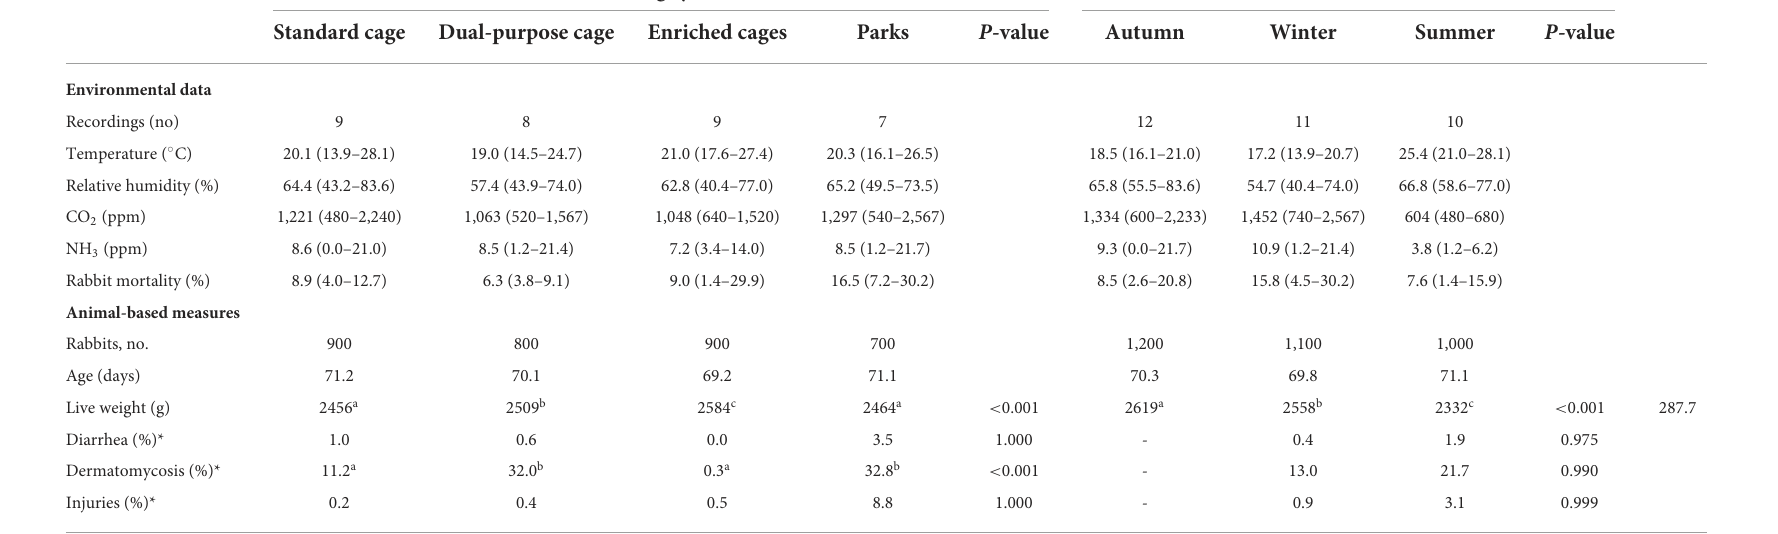
TABLE 6 Results of the pre-slaughtering visit in farms with different housing systems across three seasons: environmental (means and intervals) and animal-based measures (means) in growing rabbits. Housing